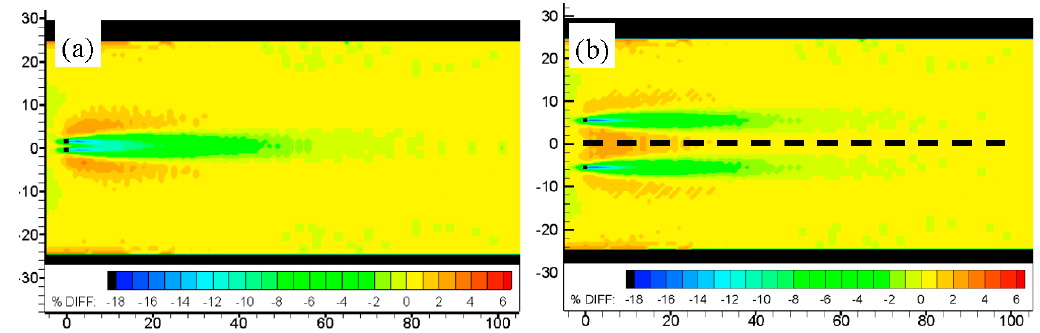
Figure 10. Changes in current speeds for two turbines deployed at ( a ) 1 RD and ( b ) 10 RD lateral spacing.